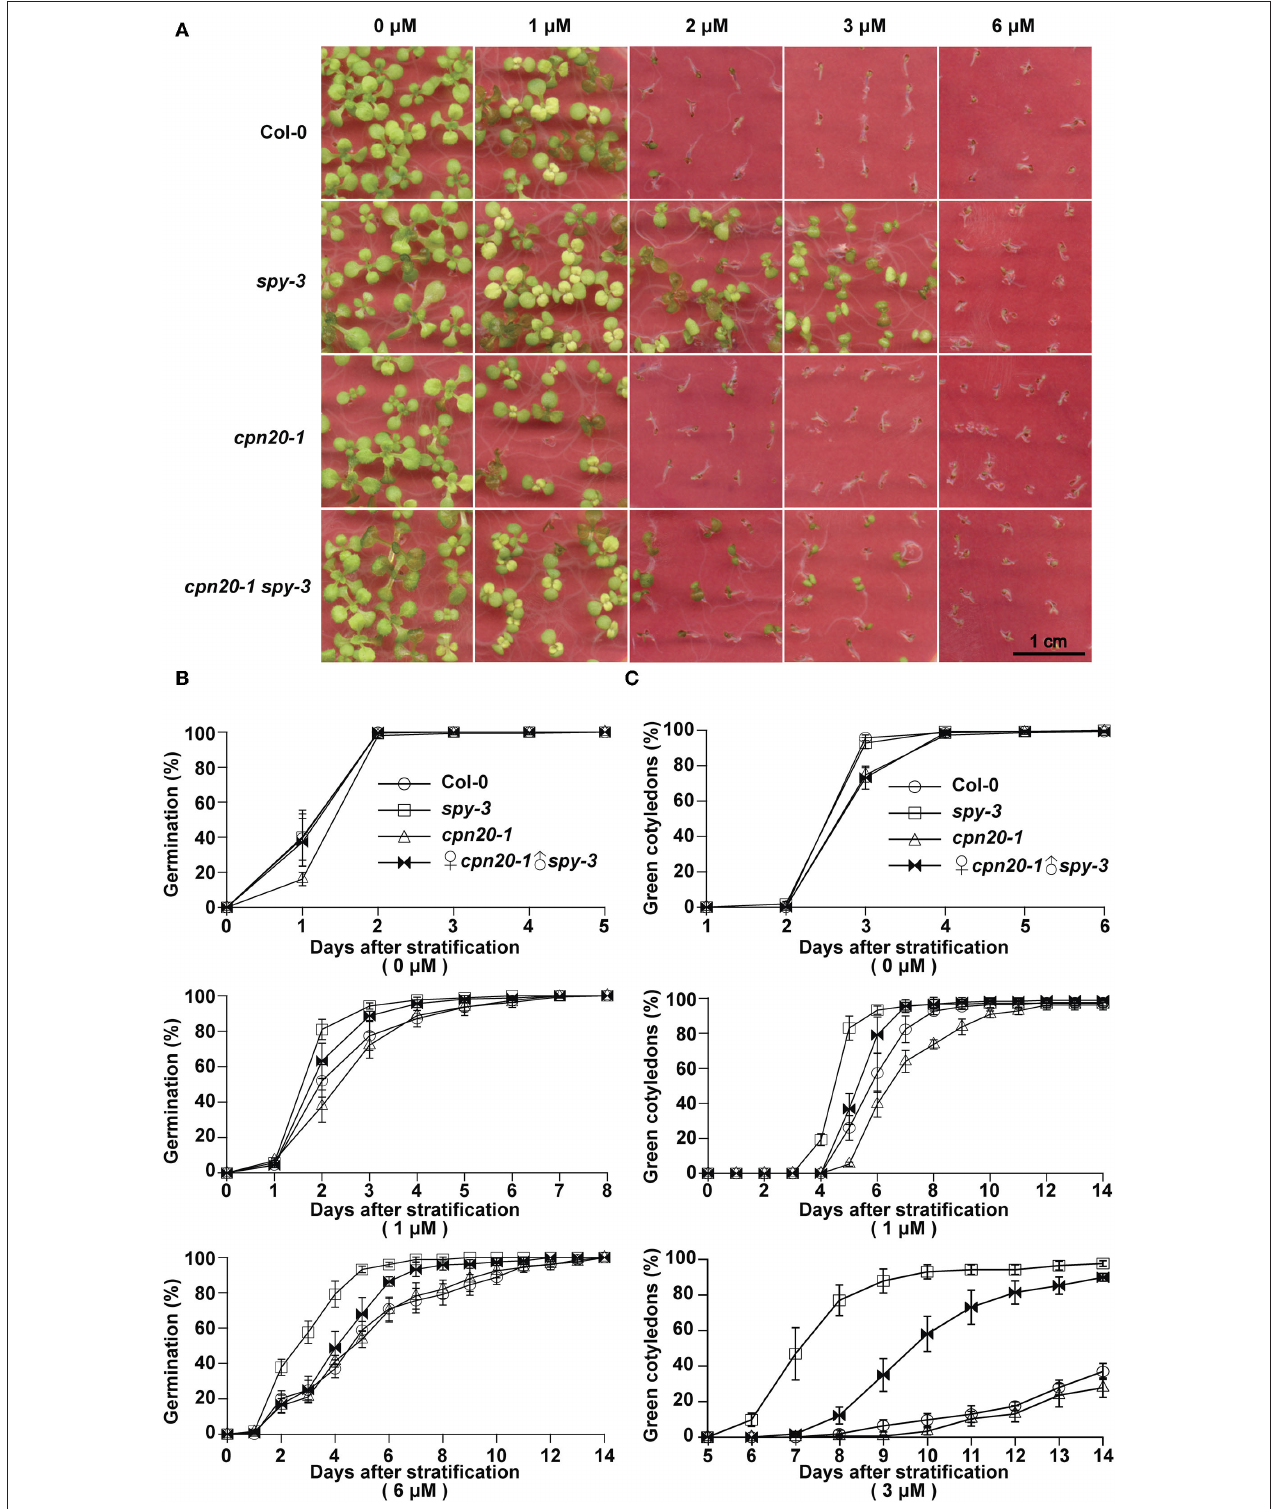
FIGURE 6 | cpn20-1 suppresses the insensitivity of spy-3 to ABA in seed germination and early seedling development. Germination rates (B) and cotyledon greening rates (C) of ♀ cpn20-1 ♂ spy-3 , cpn20-1 , spy-3 , and Col-0 under indicated concentrations of ABA were scored and calculated at indicated time after 4-day stratification at 4 ◦ C. Data are shown as means ± SE of four replicates. Images of 2-week seedlings were taken (A) .